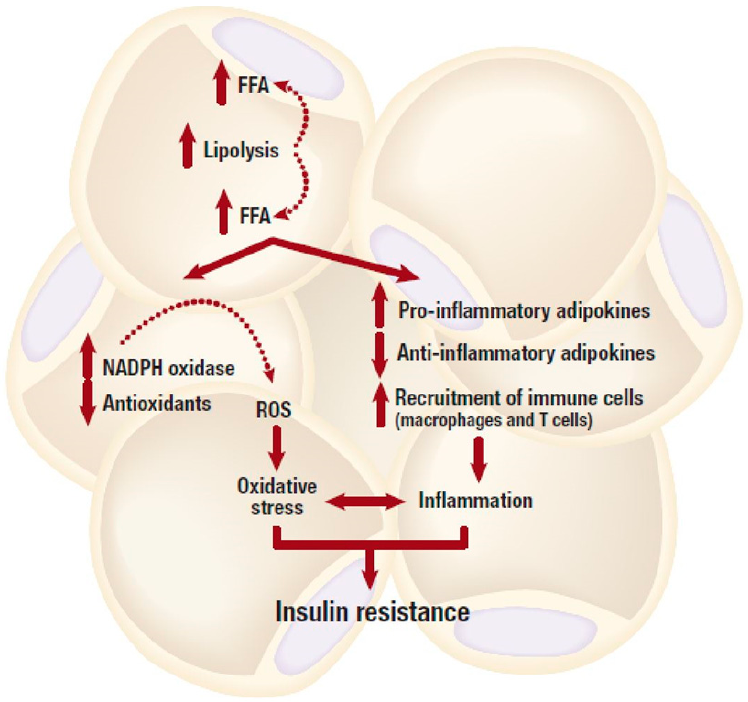
Figure 2. An obese state is associated with dysfunctional lipid metabolism including excessive lipolysis, which in turn leads to increased production and secretion of free fatty acids (FFAs). Elevated FFA levels can cause an abnormal pro-inflammatory response, and subsequent development of insulin resistance. Whereas, depleted intracellular antioxidant systems in the adipose tissue, mainly due to increased production of reactive oxygen species (ROS) can generate oxidative stress, and this can further lead to the development of insulin resistance. NADPH, nicotinamide adenine dinucleotide phosphate.